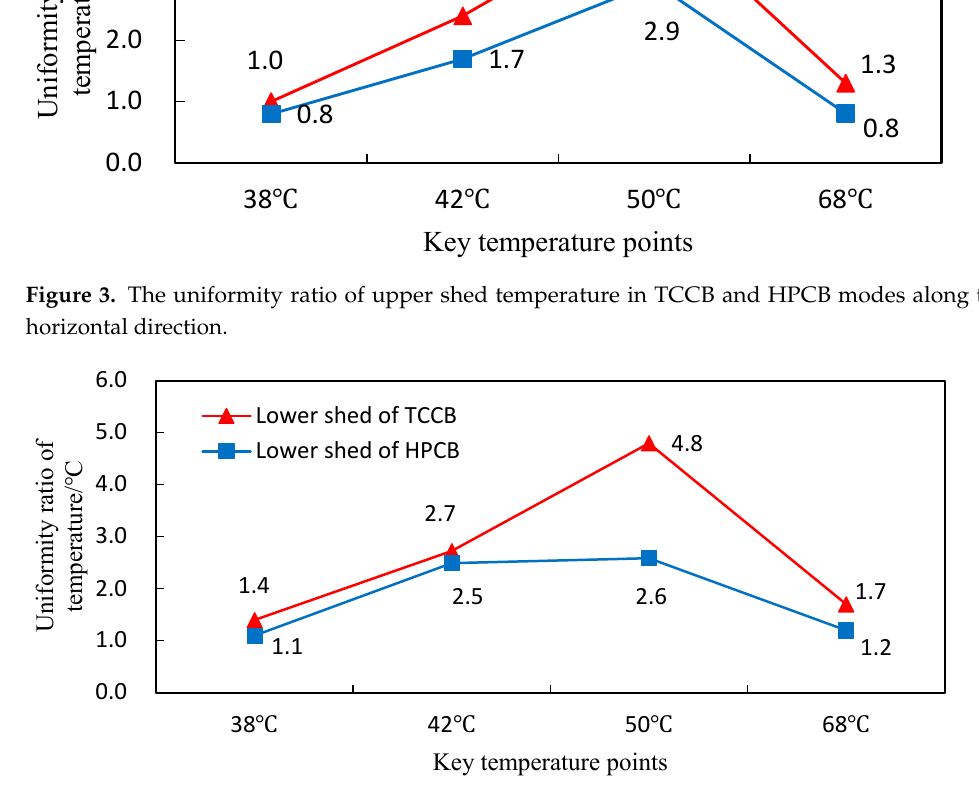
Figure 4. The uniformity ratio of lower shed temperature in TCCB and HPCB modes along the horizontal direction.